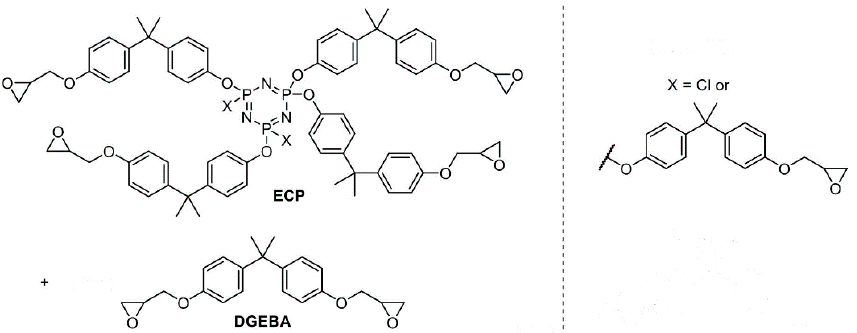
Figure 1. The general formula of epoxycyclophosphazene resin (products of the reaction of epichlorohydrin with hydroxyaryloxycyclotriphosphazenes). Epoxycyclophosphazene oligomer (ECP), diglycidyl ether of bisphenol A (DGEBA).